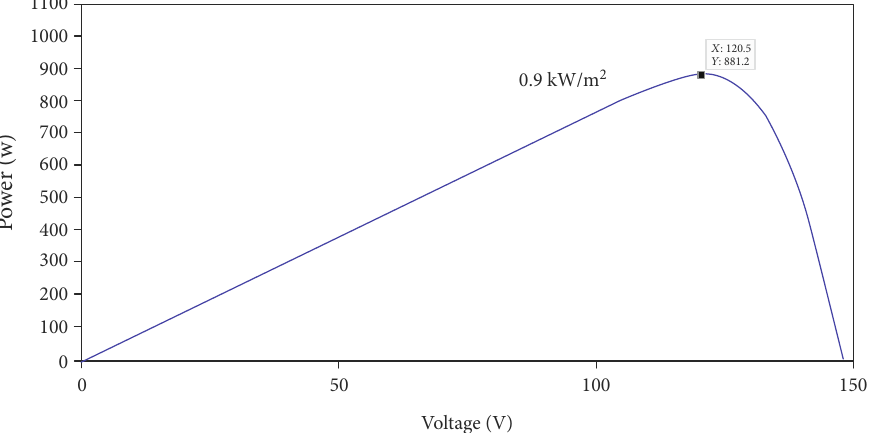
Figure 17: P-V characteristic of the PV array for 900W/m 2